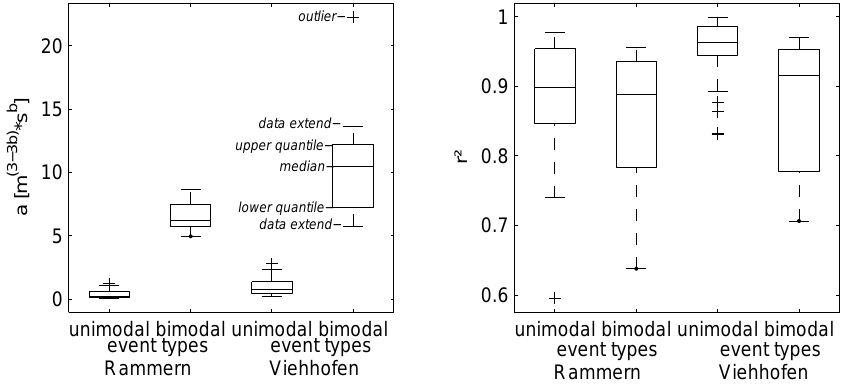
Fig. 11. Boxplots of coefficient a (left) calculated with the nonlinear model with goodness of curve fit r 2 (right) for the two event types at the small-catchment scale (gauge Rammern) and at the meso-scale (gauge